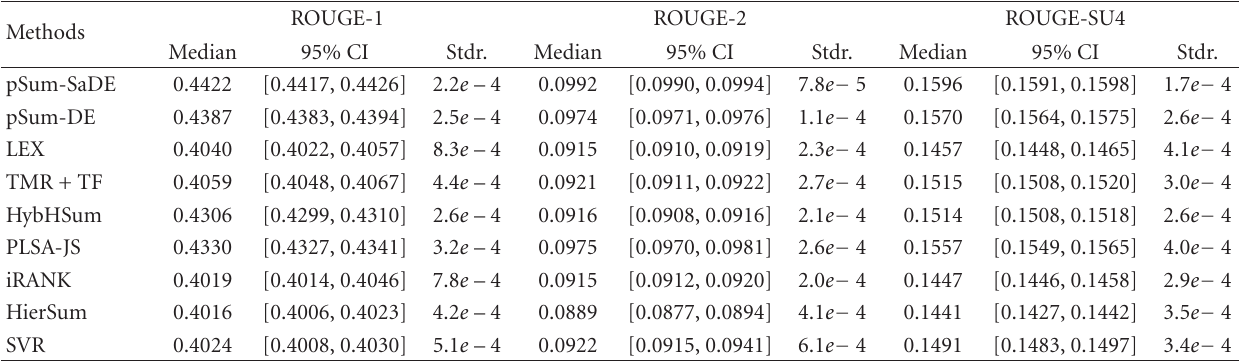
Table 6: Median values, 95% CI, and standard error of ROUGE scores over 20 consecutive runs of methods. Methods